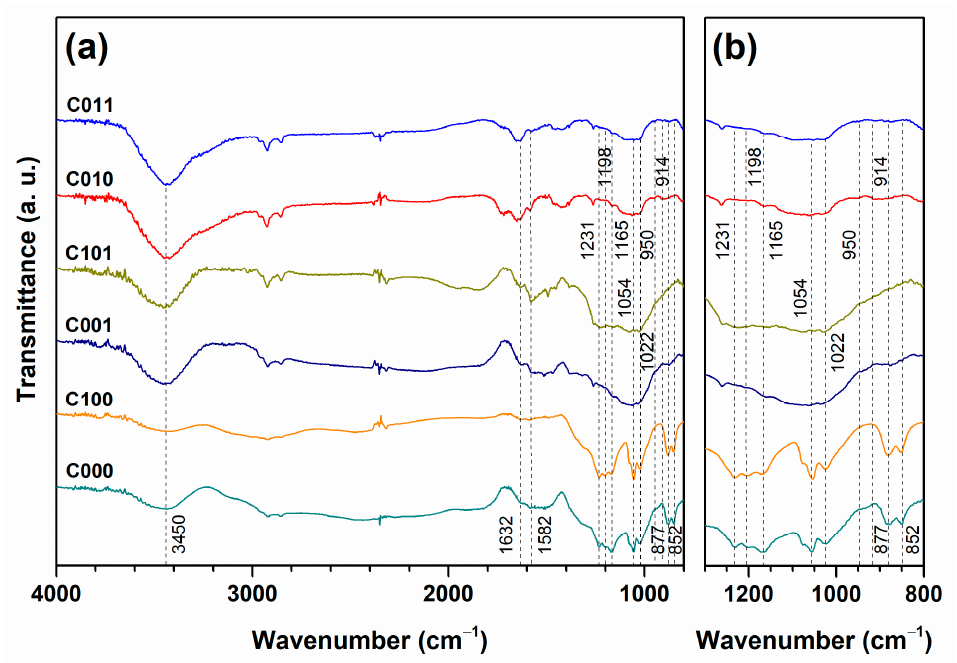
Figure 9. FTIR spectra of GBS products obtained using CrO 3 oxidizing agent in the region of 4000–800 cm − 1 ( a ) and 1300–800 cm − 1 ( b ).